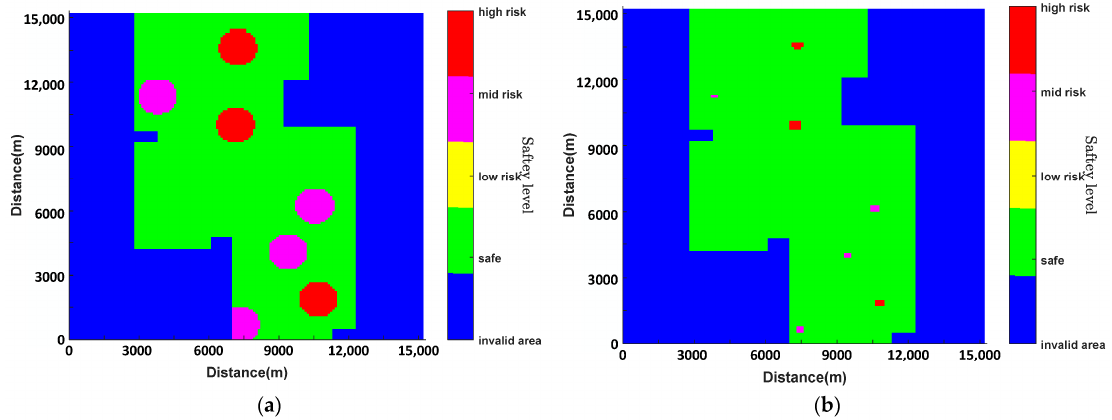
Figure 10. Special-area layers. ( a ) Layer for Talon; ( b ) Layer for DJI Inspire 2.